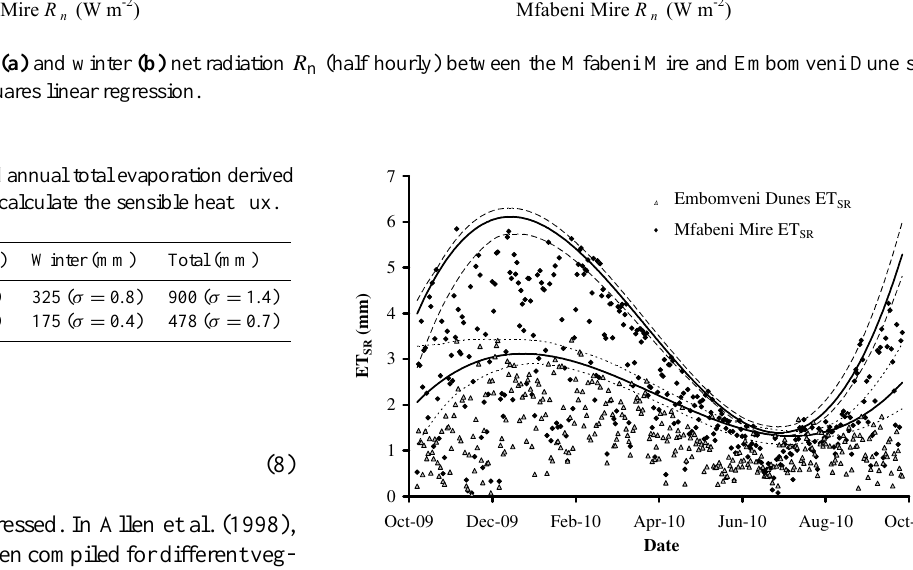
Fig. 7. Daily total evaporation at the Mfabeni Mire (upper line) and Embomveni Dunes (lower line) from October 2009 to Septem- ber 2010 using the surface renewal technique. Solid lines represent fitted 95% regression quantiles and dashed lines their 95% confi- dence